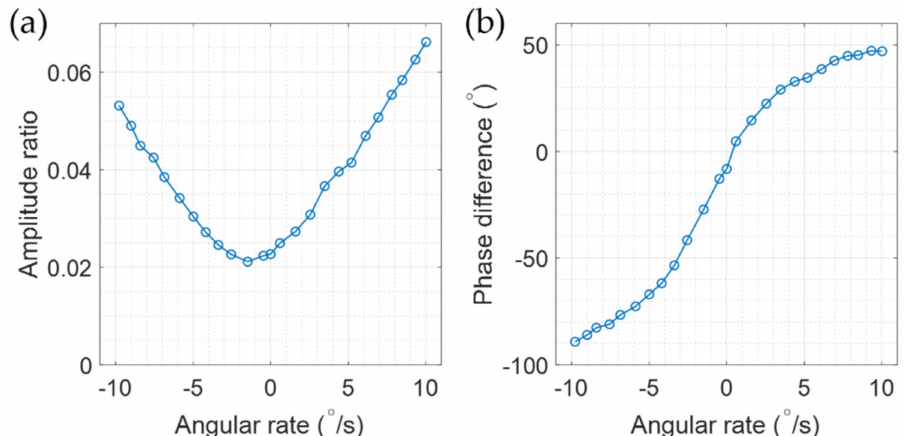
Figure 11. The amplitude ratio y/x measured at several angular rates: ( a ) the magnitude and ( b ) the phase of the ratio. The magnitude variation is not linear to the applied angular rate, and does not vanish at any rate. The phase varies with the angular rate but the sign of the phase is not changed exactly at the zero